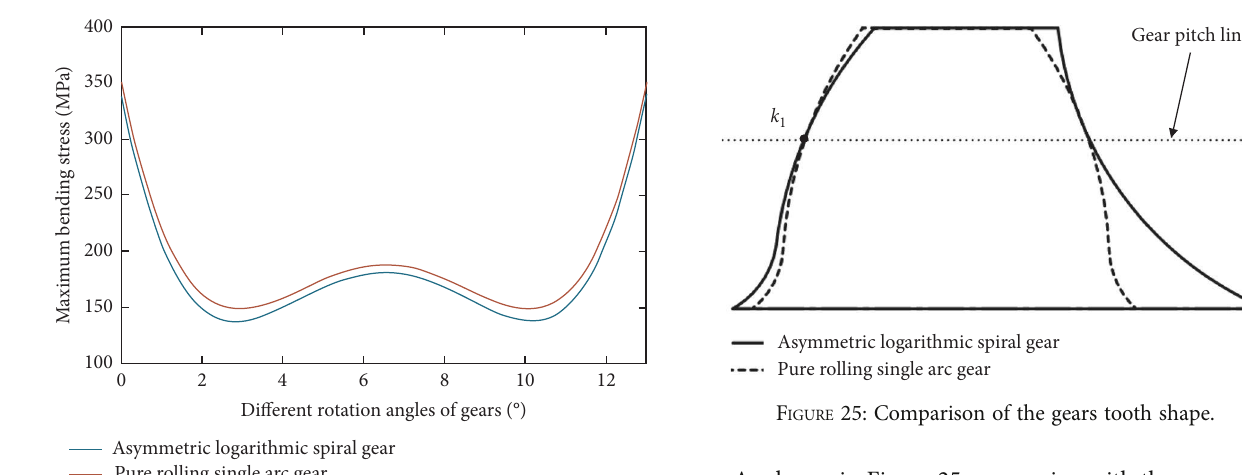
F IGURE 25: Comparison of the gears tooth